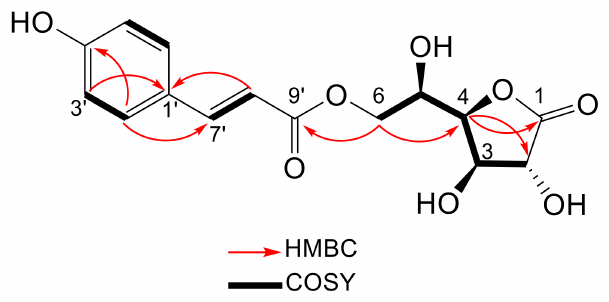
Figure 4. Key HMBC and 1 H 1 H COSY correlation of compound 3